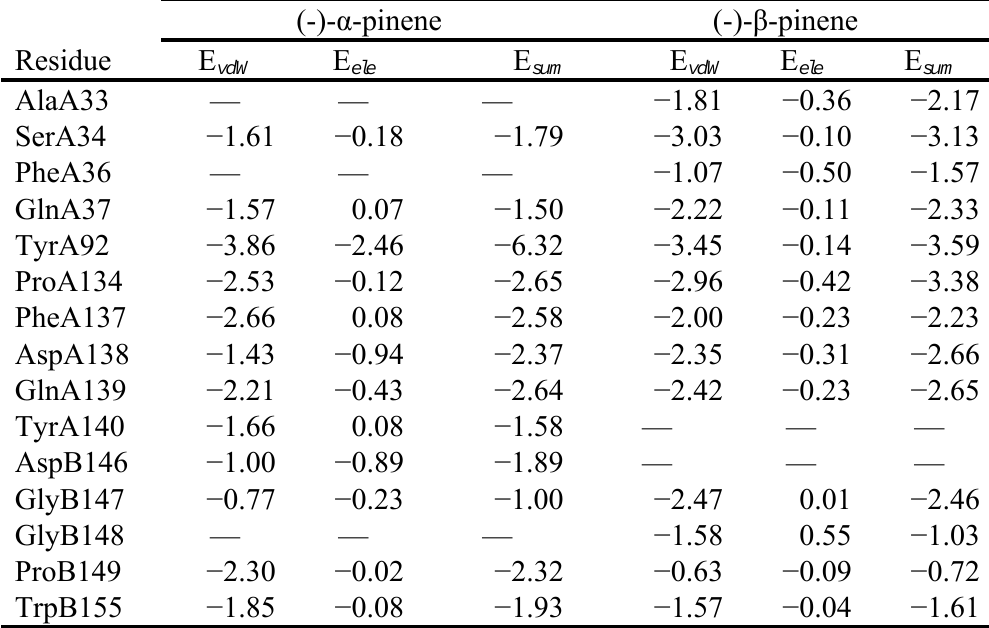
Table 2. The vdW, electrostatic and sum interaction energies (E involving (-)- α -pinene and (-)- β -pinene with the active-site residues of nucleocapsid (N) protein a